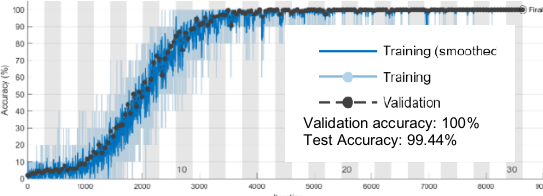
Fig. 13. Validation Accuracy of SqueezeNet Range-Speed